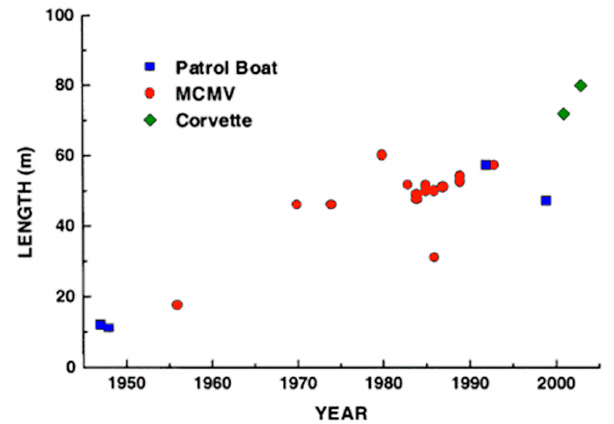
Figure 1. Plot of vessel length against the year of construction for all-composite patrol boats, mine-countermeasures vessels (MCMVs) and corvettes against the year of construction [5].